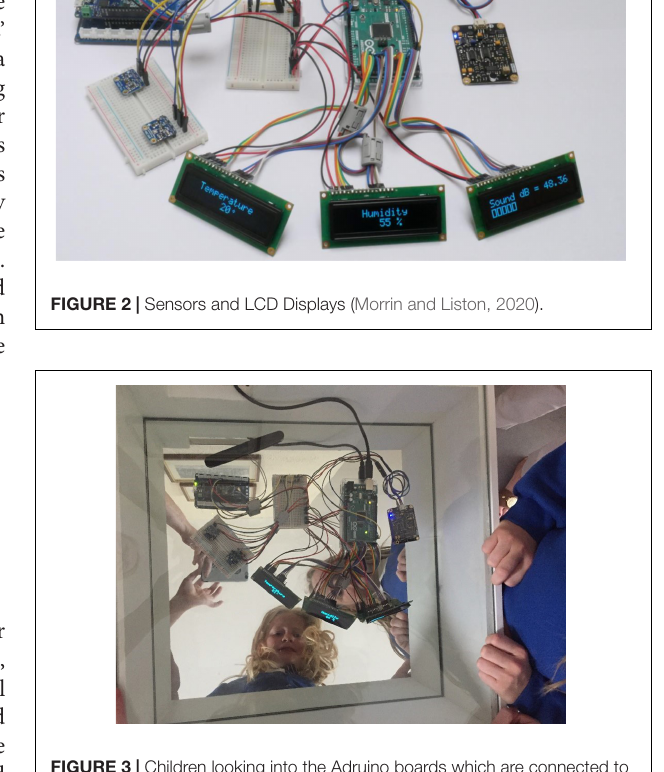
FIGURE 3 | Children looking into the Adruino boards which are connected to sensors, collecting data on light, humidity, temperature, and sound levels of the school environment (Morrin and Liston,